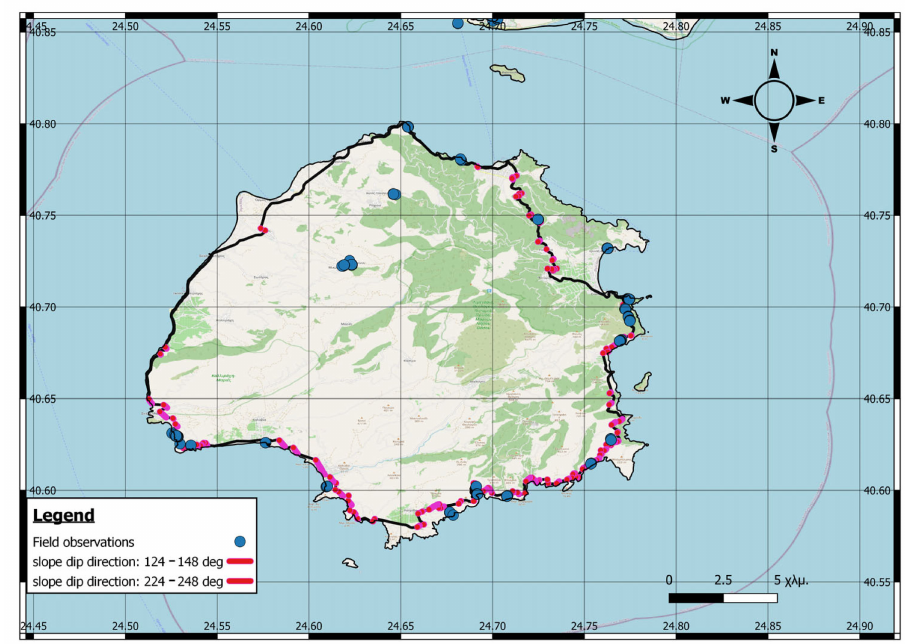
Figure 14. Map of the island of Thasos indicating the road network segments that have cut slopes with dip direction within the critical